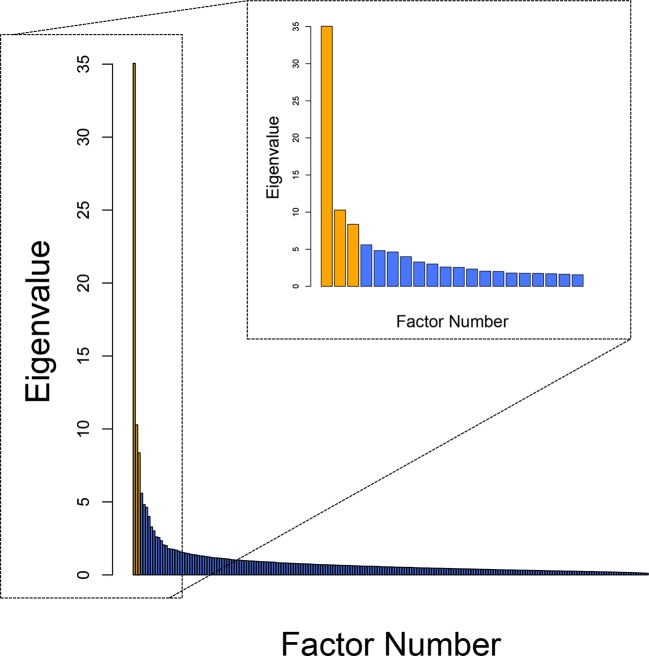
Scree plot of eigenvalues.The outer frame shows the eigenvalues for every possible factor solution, N=209. Inset is data for the first 20 potential factor solutions only. An empirically defined elbow, where Eigenvalues begin to level out, was identified at factor 4 using the nFactors package in R, provideing evidence for a 3-factor solution (Cattell, 1966), indicated in orange.*p<0.05 **p<0.01 ***p<0.001.